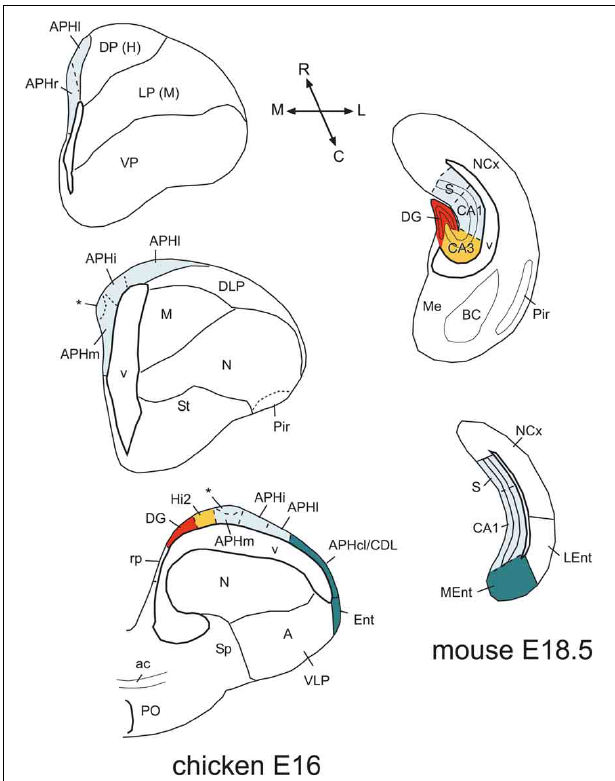
FIGURE 12 | Comparison of chicken and mouse medial pallial subdivisions. Schematic drawings of frontal sections through the telencephalon of a chicken (at E16) and a mouse (at E18.5), at rostral intermediate, or caudal levels, showing the major subdivisions of the medial pallium. A color code is used to compare these subdivisions between species. In these schemes, dorsal is to the top and medial is to the left. In the chicken, the rostralmost part is represented by the APHr. The asterisk points to an ectopic part of chicken APHr (possibly a group tangentially migrated cells), observed at the surface of APHm at intermediate and caudal levels of the medial pallium. The rostralmost part of mouse is not represented here, but appears to include the indusium griseum. For abbreviations see list. See text for more